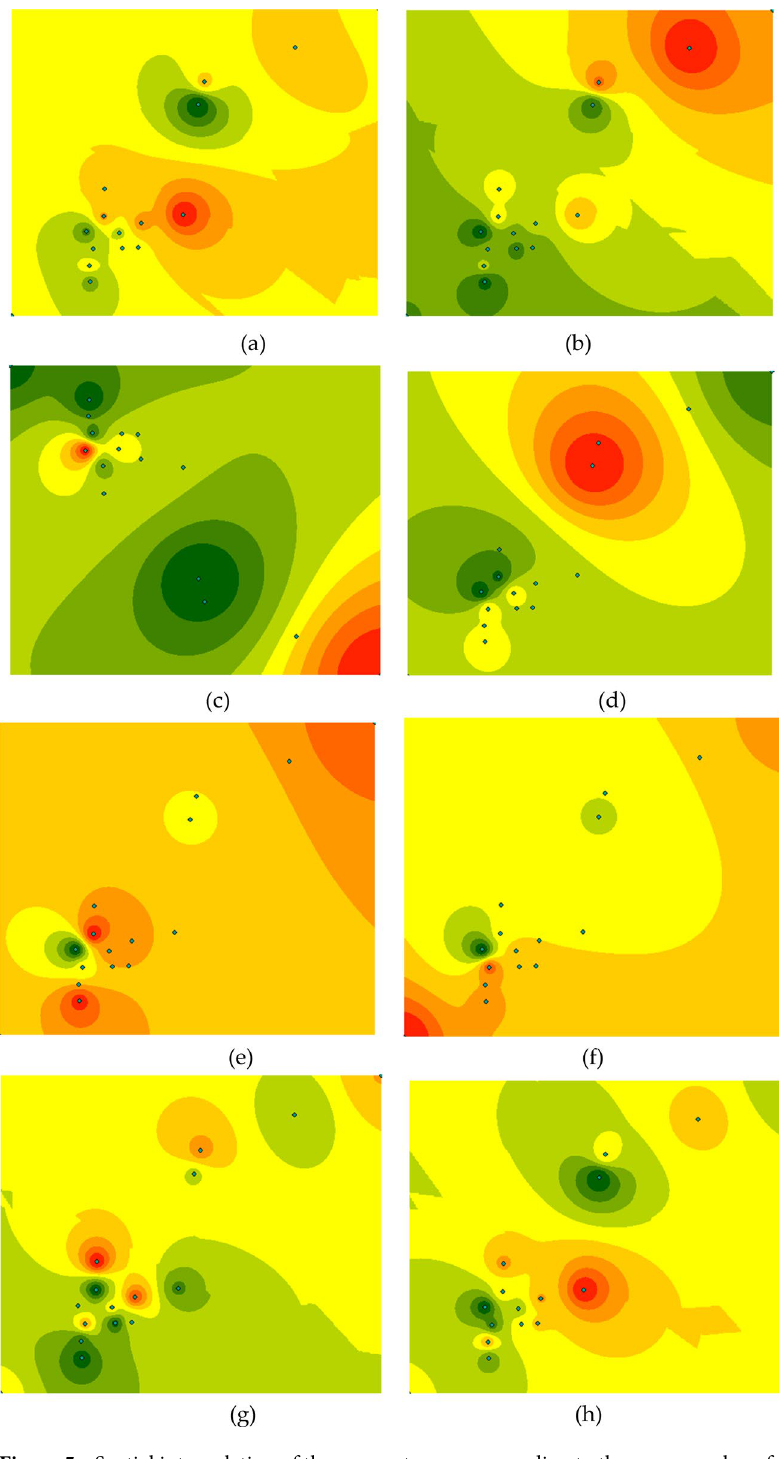
Figure 5. Spatial interpolation of the parameters corresponding to the average value of the data collected on March 3, 2018. ( a ) PM2.5 concentration ( b ) PM10 concentration ( c ) SO2 concentration ( d ) NO2